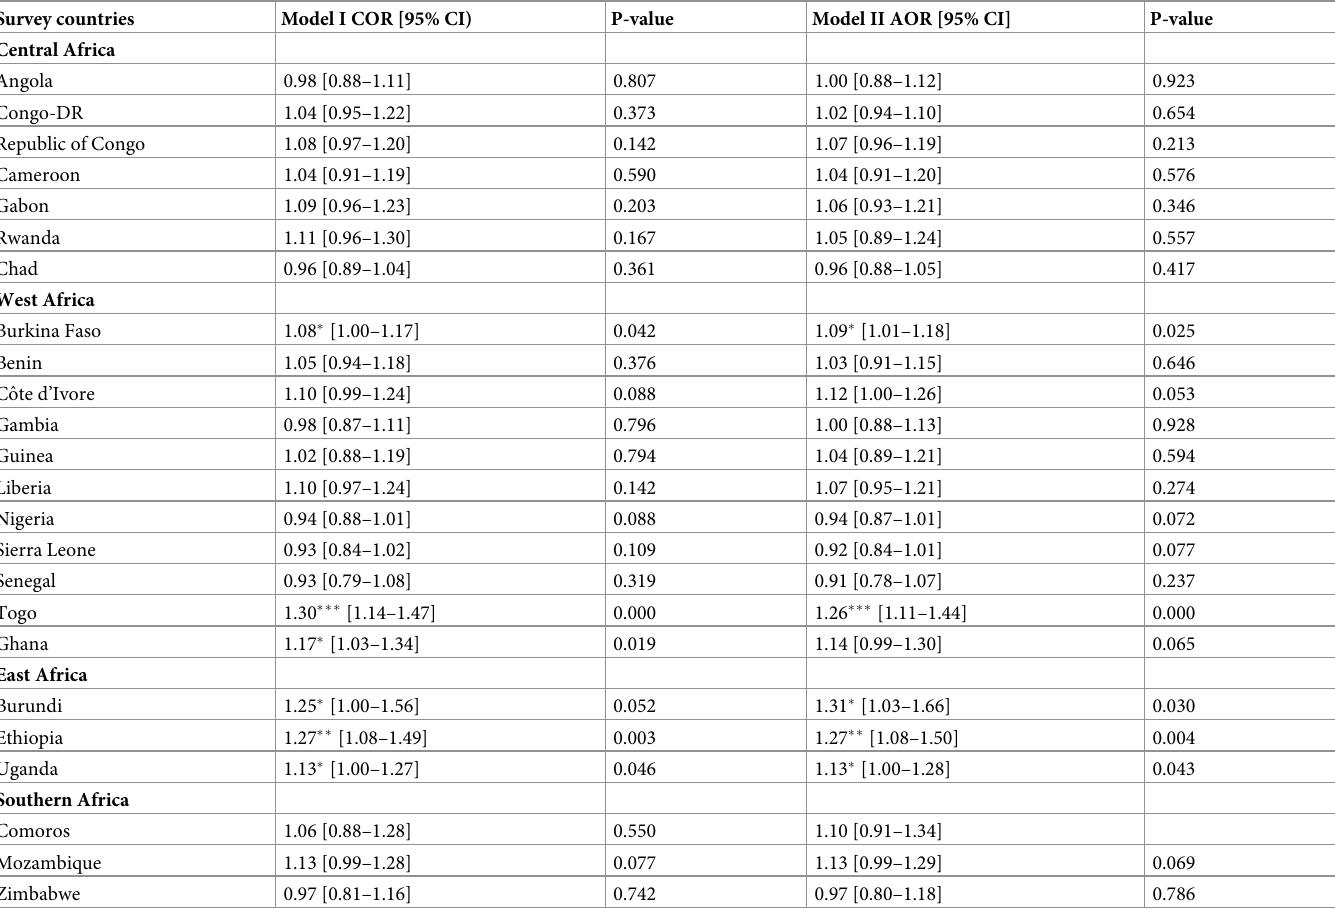
Table 4. Bivariate and multivariable models showing the effect of sex of child and early initiation of breastfeeding among women in sub-Saharan Africa countries. Survey countries